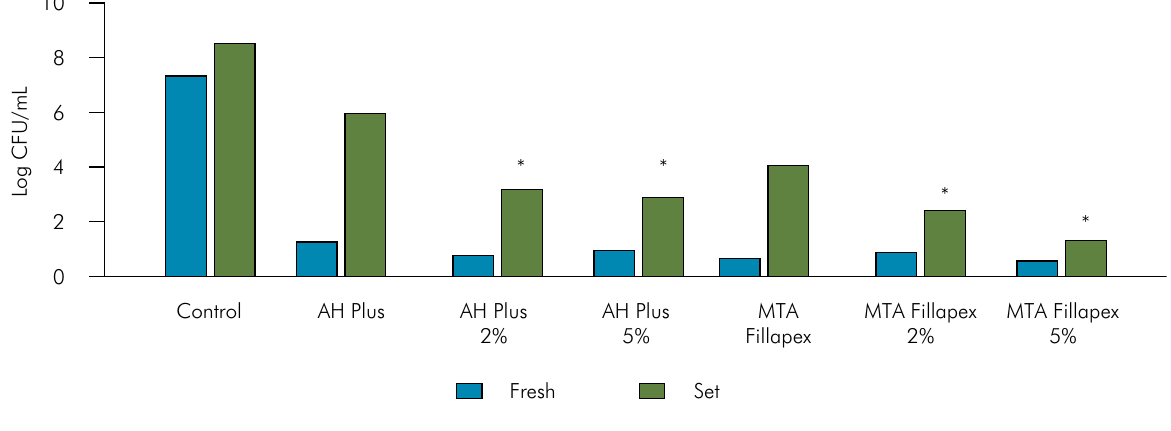
Figure 1. Antimicrobial activity (CFU/mL) of tested sealers both freshly prepared and after 7 days of